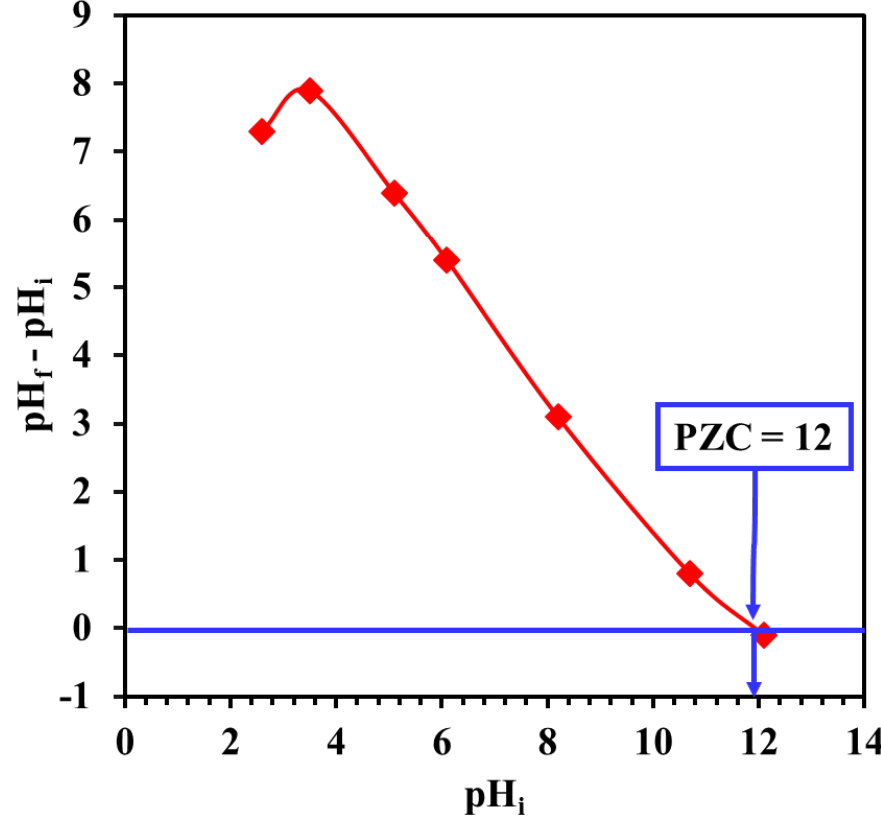
Figure 9. Determination of point of zero charge (pH PZC ) for Mg-Ca-Al-LDO composite by the pH drift method.